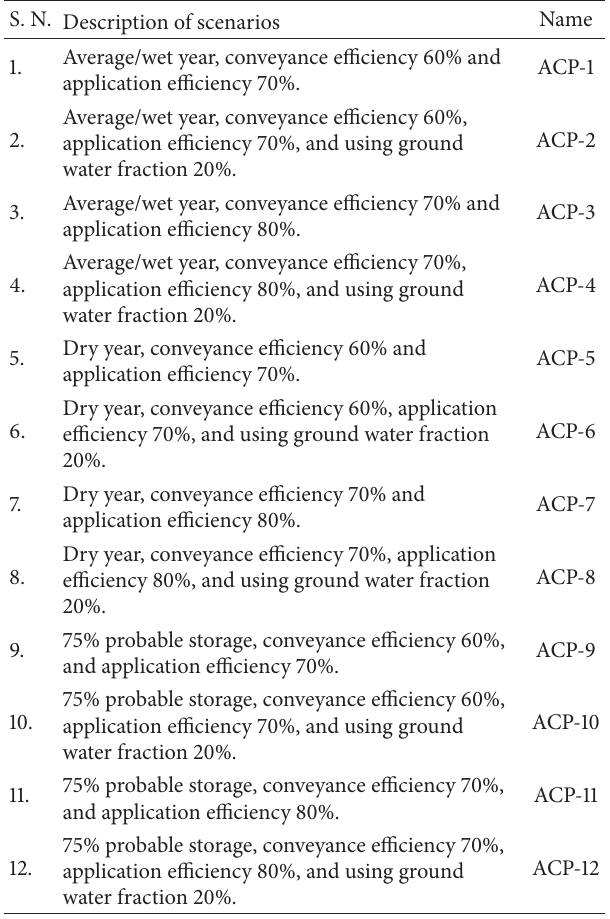
Table 4: Details of sowing date, crops, and cropped area of existing cropping